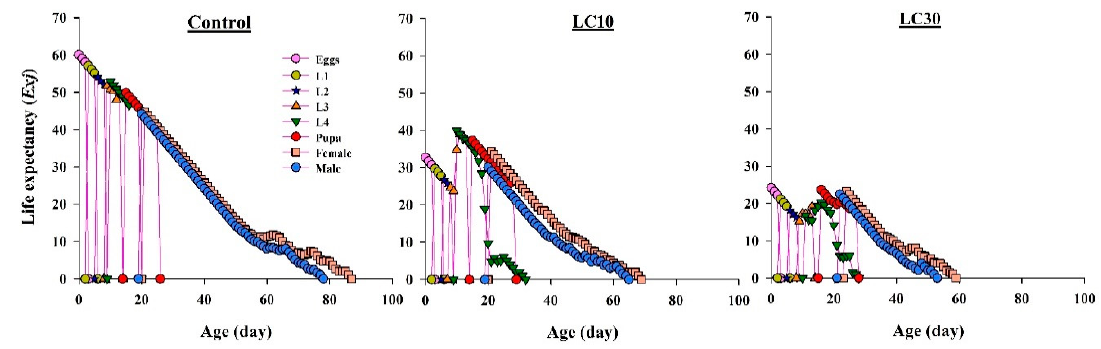
Figure 4. Graphs show e xj (Life expectancy) values for offspring produced by H. axyridis females treated with sublethal chlorpyrifos concentrations.